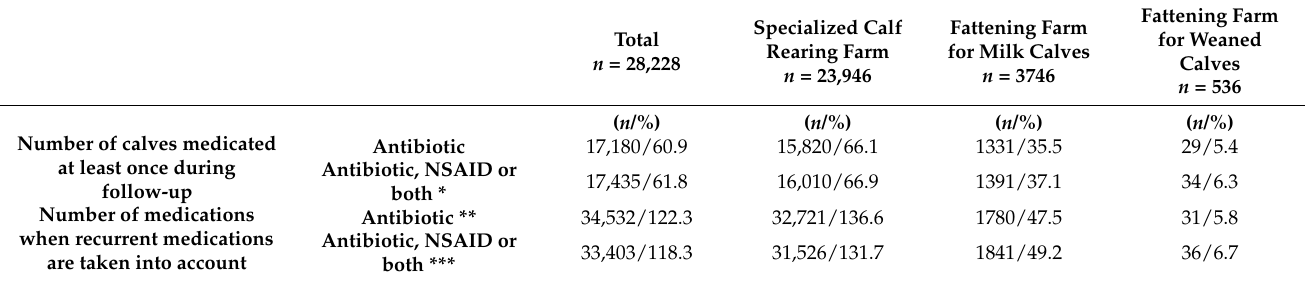
Table 1. Number of separate medications given to study calves ( n = 28,228) during the 180-day follow-up.